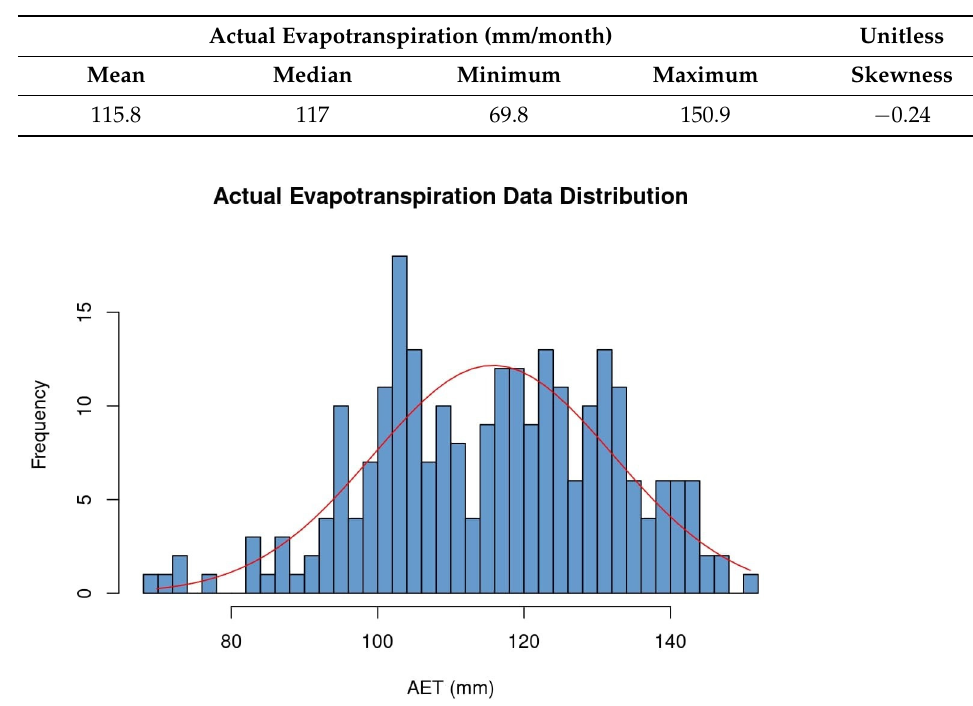
Figure 3. Histogram of the data distribution with the normality curve.